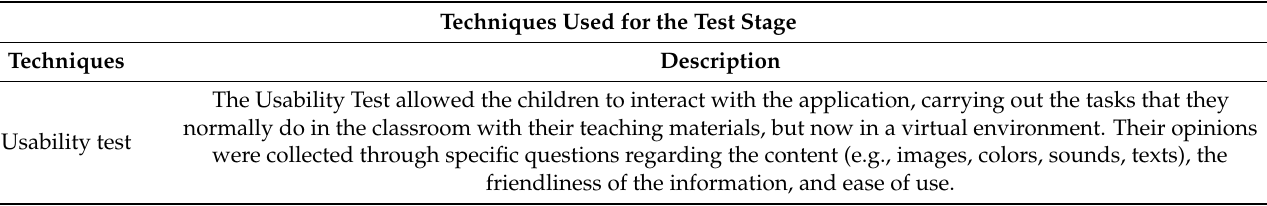
Table 7. Description of techniques used in the Test or Evaluate stage.